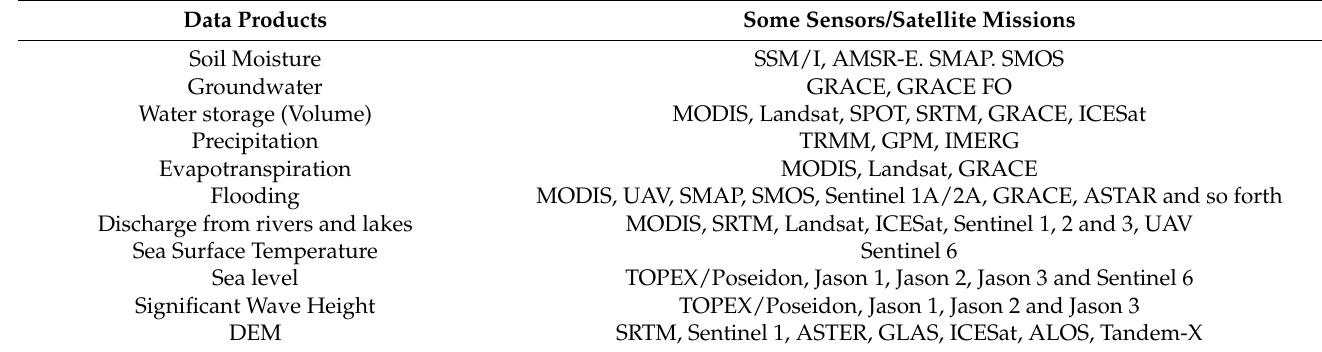
Table A6. Summary of Remote Sensing Sensors and data input products.